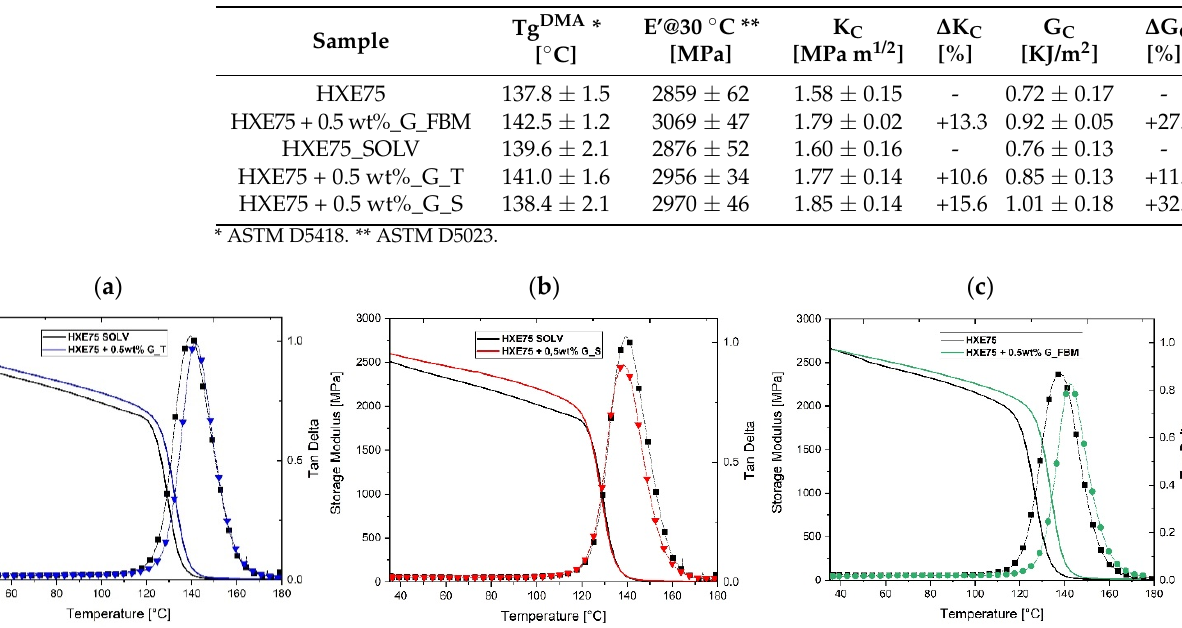
Figure 4. DMA analysis performed on the neat epoxy matrix and the GNP based nanocomposites. ( a ) HXE75 + 0.5 wt% G_T. ( b ) HXE75 + 0.5 wt% G_S. ( c ) HXE75 + 0.5 wt% G_FBM.